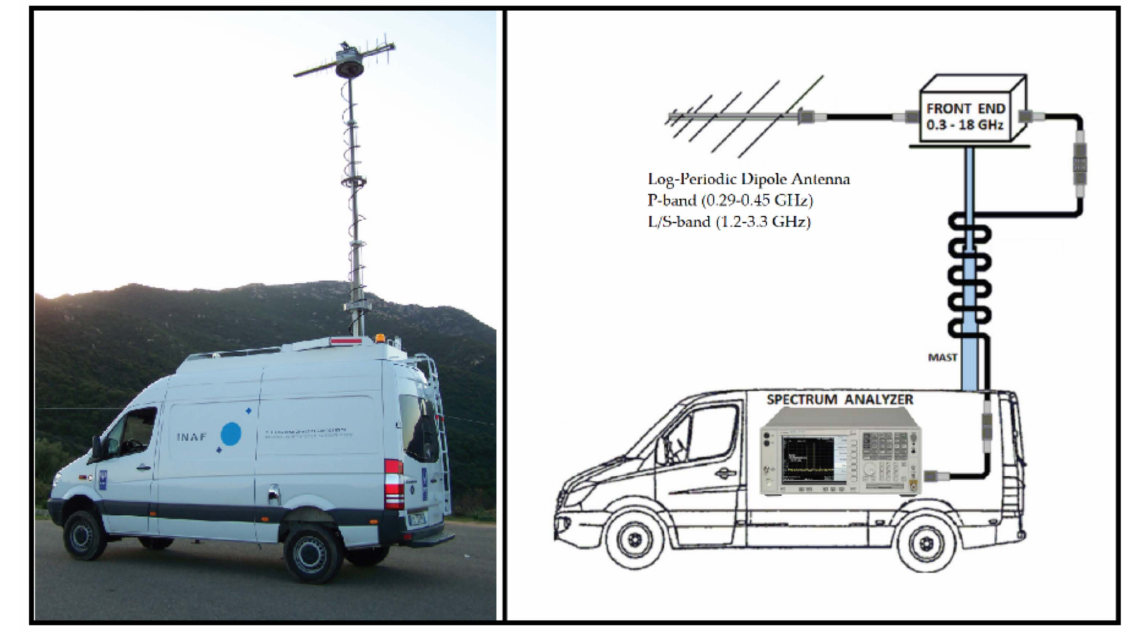
Figure 7. The RFI mobile laboratory